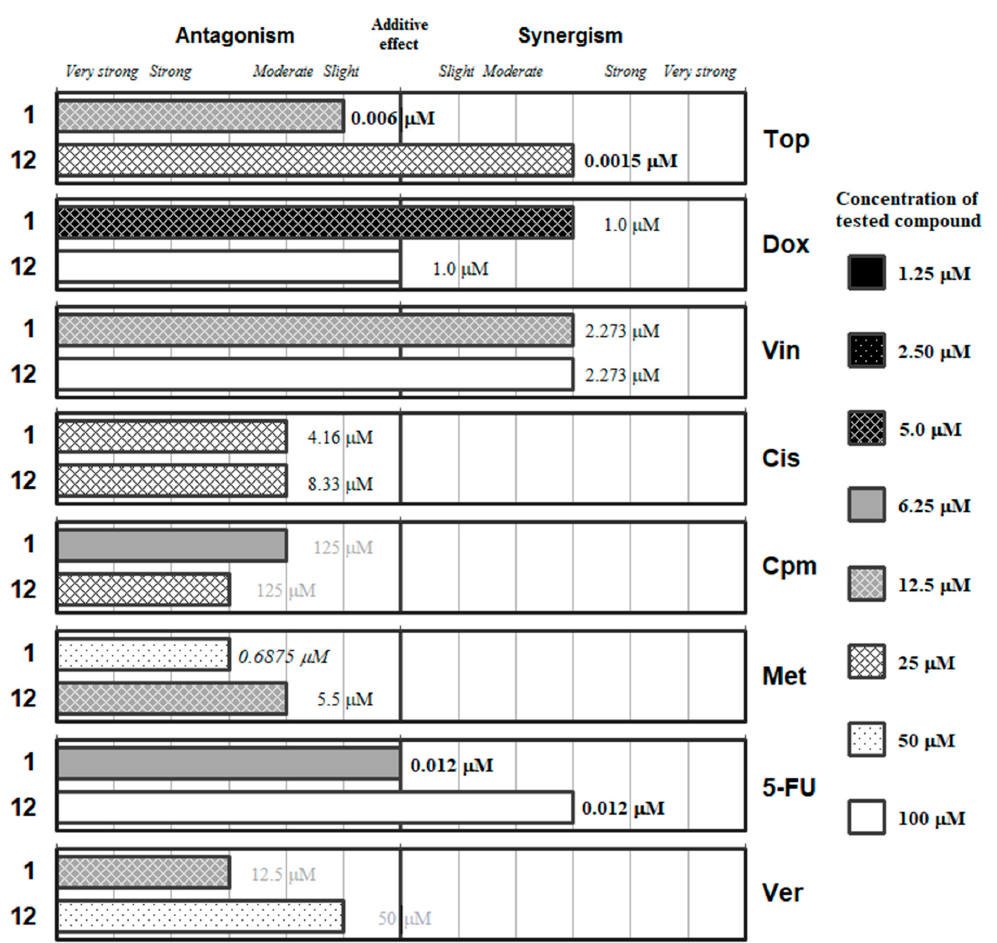
Figure 2. Interactions of the phthalic selenoanhydride ( 1 ) and the phthalic anhydride ( 12 ) with a panel of anticancer drugs (topotecan [ Top ], doxorubicin [ Dox ]), vincristine [ Vin ]), cisplatin [ Cis ], cyclophosphamide [ Cpm ]), methotrexate [ Met ] and 5 ‐ fluorouracil [5 ‐ FU ]) or an efflux pump inhibitor (Verapamil [ Ver ]). Concentration of the tested compound is given according the legend; concentration of the anticancer drug is given in numbers inside the graph (in bold: below 0.1 μ M, in italics between 0.1 µ M and 1 µ M, and in grey above 10 µ 0.1 μ M and 1 μ M, and in grey above 10 μ M).